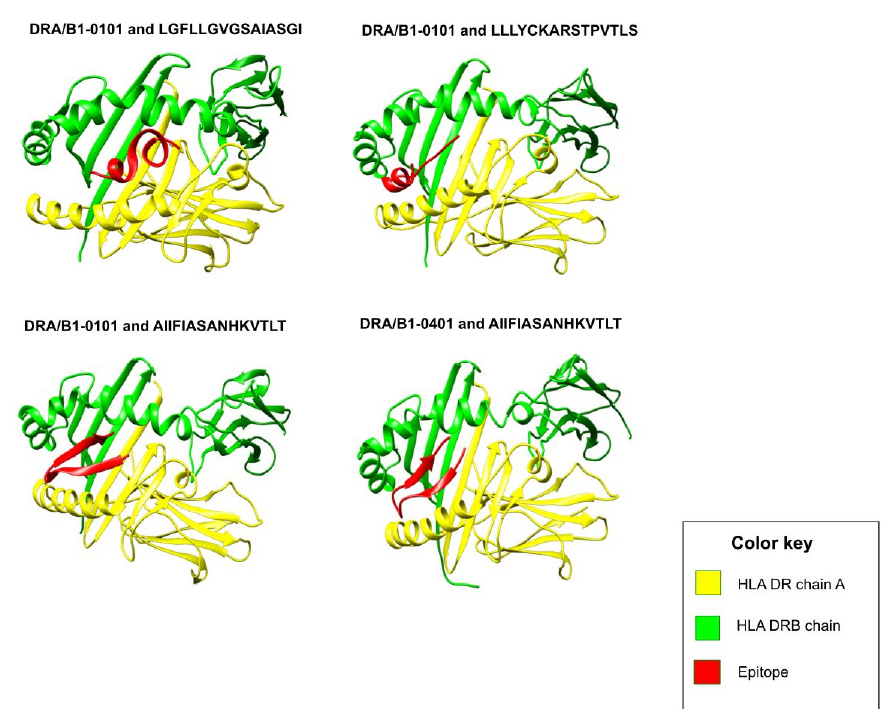
Figure 2. Figure showing structural interactions between the prioritized HLA II epitopes (colored in red) and cognate HLA II chains (colored in yellow and green). Out of all the HLA II epitopes, AIIFIASANHKVTLT (from the G glycoprotein) showed the best HADDOCK scores of − 117.4 and − 117.1 with HLA DRA/B1*0101 and HLA DRA/B1*0401, respectively. It can be observed that all the epitopes fit comfortably inside the binding groove of the HLA molecule (formed between the two HLA chains shown in yellow and green color, respectively), and thus are projected to interact strongly with their cognate HLA II allele.